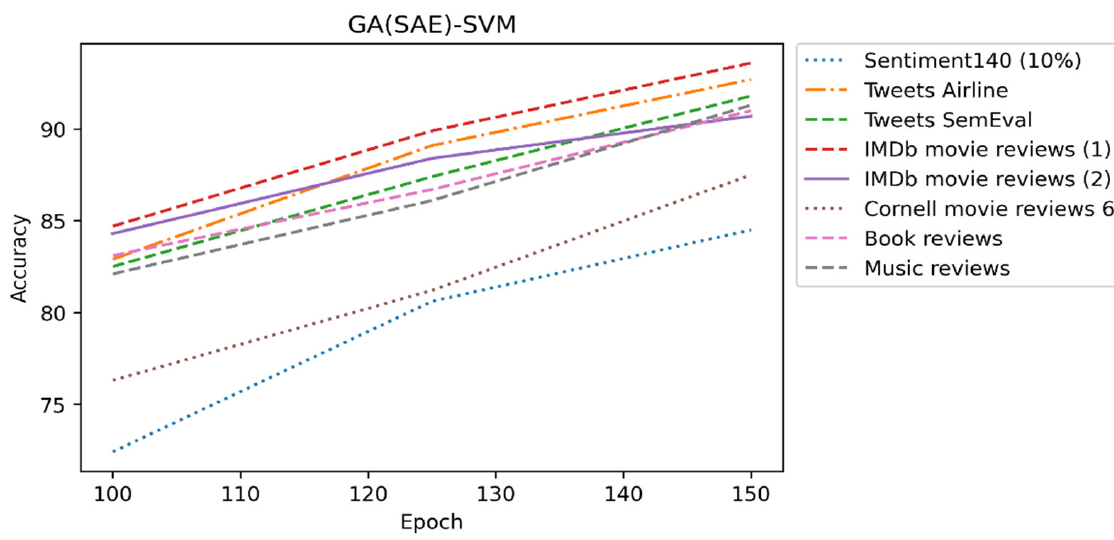
Figure 7. Epoch impact of GA(SAE)-SVM on all datasets.